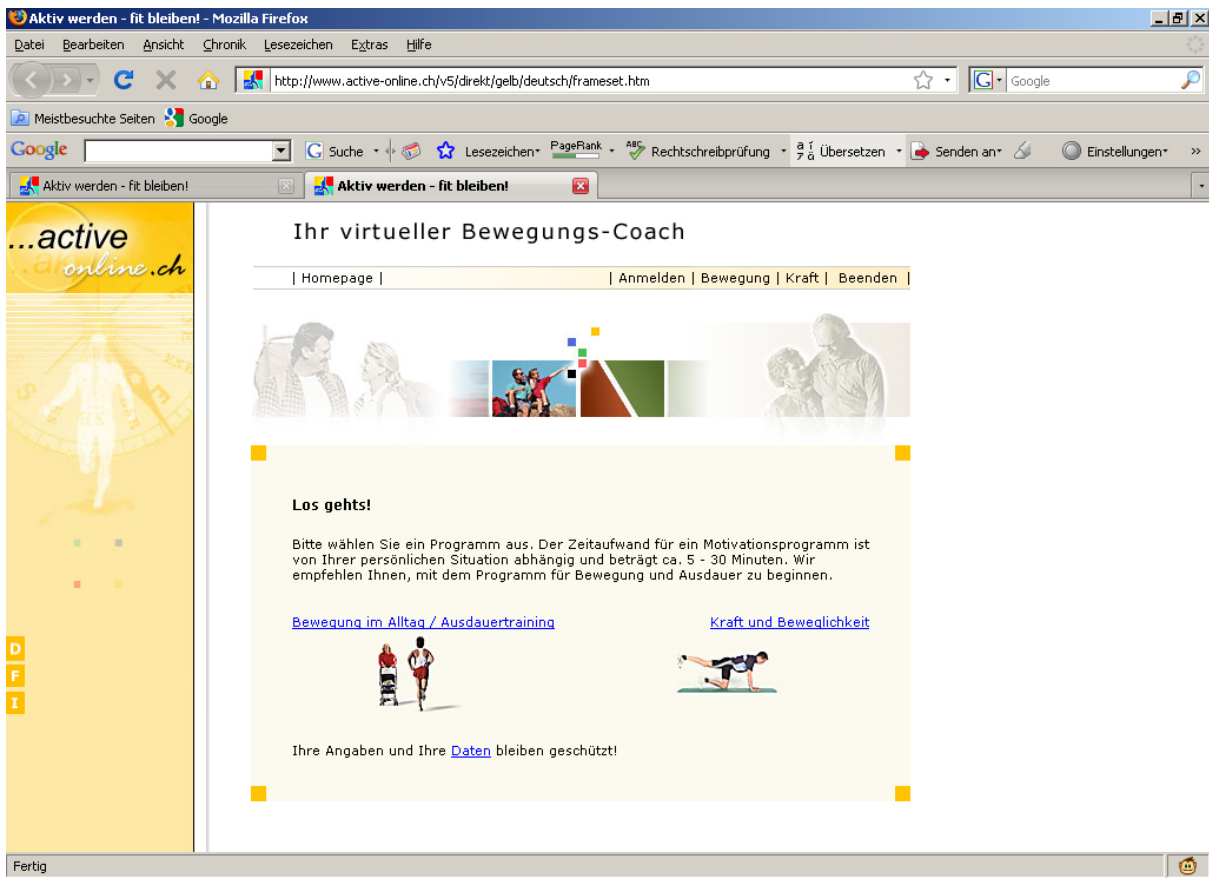
Figure 2. Screenshot of the tailored intervention